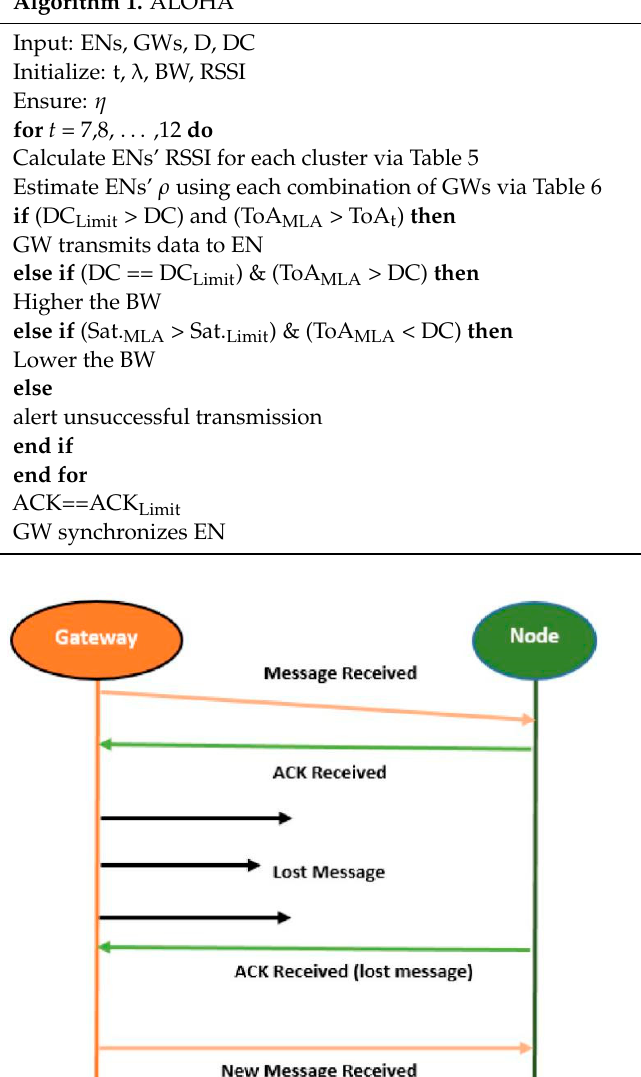
Figure 5. Synchronization acknowledgment. Algorithm 2 represents the ACK technique, which is based on synchronization rather than retransmission. The ToA and ACK’s time depend on the locality of the EN. Thus, ENs at higher SFs have higher synchronization times as compared to ENs at lower SFs. The same strategy is applied to both uplink and downlink.